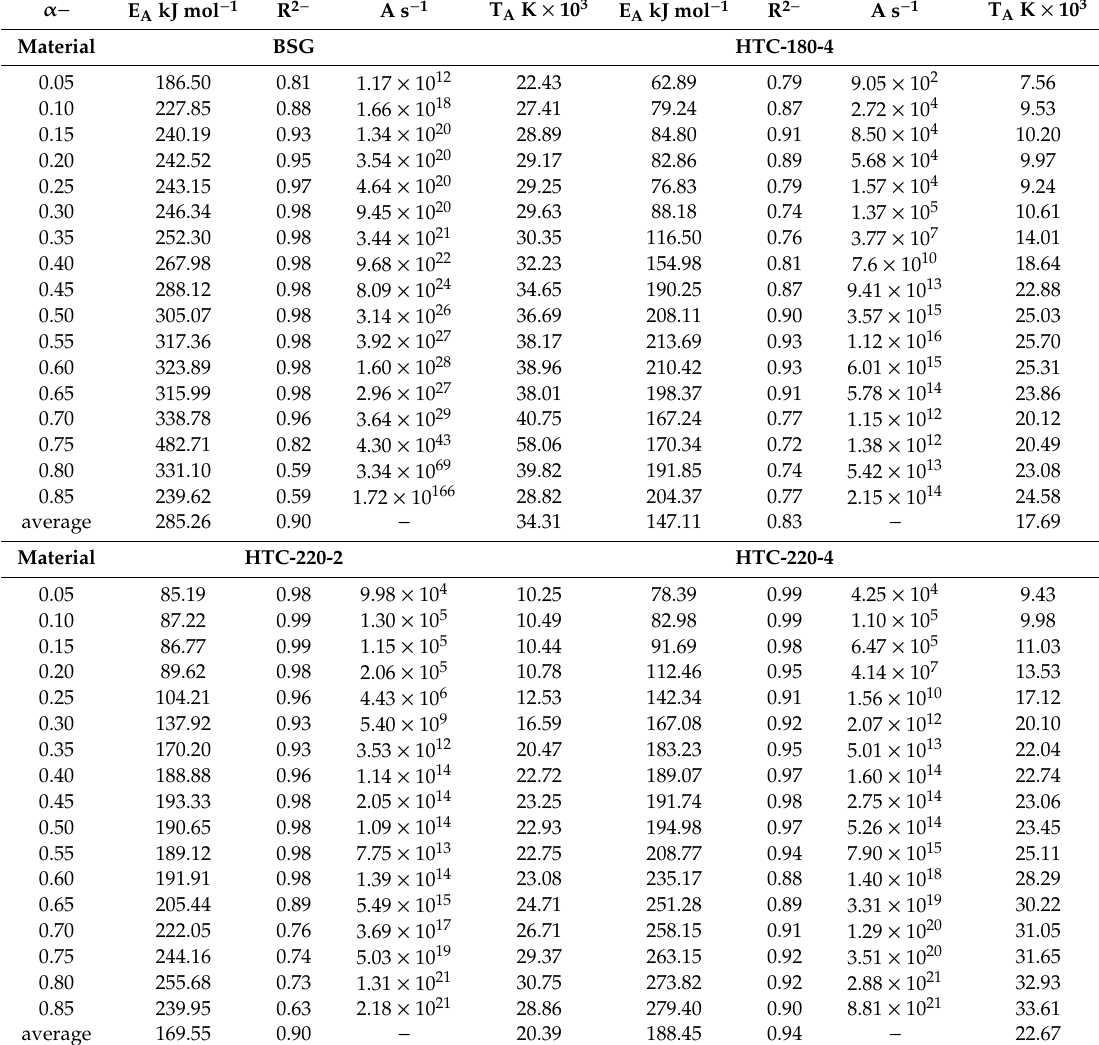
Table A2. Summary of the kinetic parameters for brewer’s spent grains and its